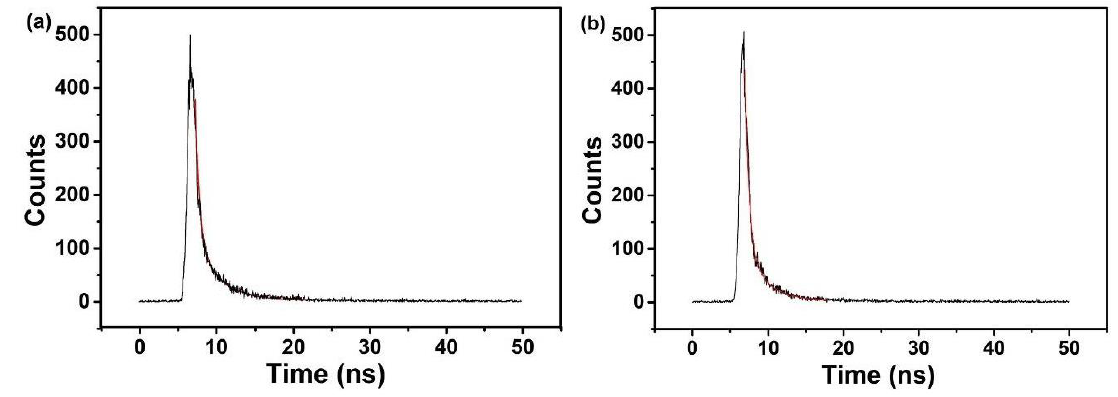
Figure 7. Fluorescence attenuation curve and fitting results: ( a ) ON-CQDs; ( b ) WN-CQDs.